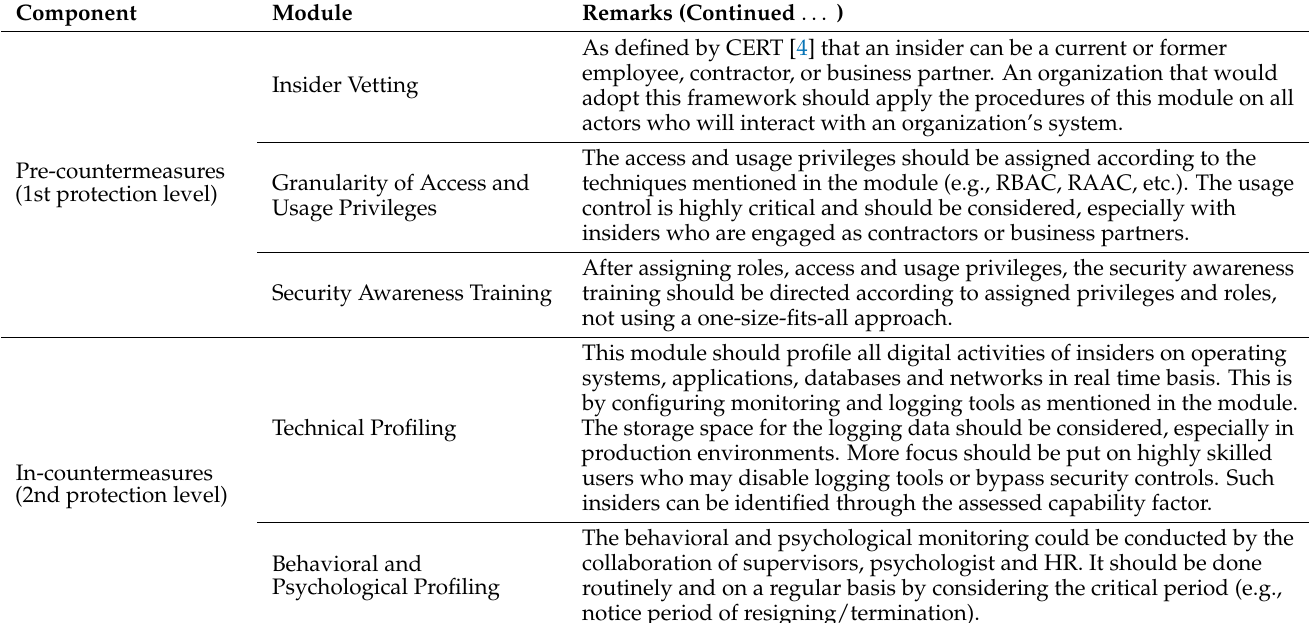
Table 7. A summary of the components and modules of the